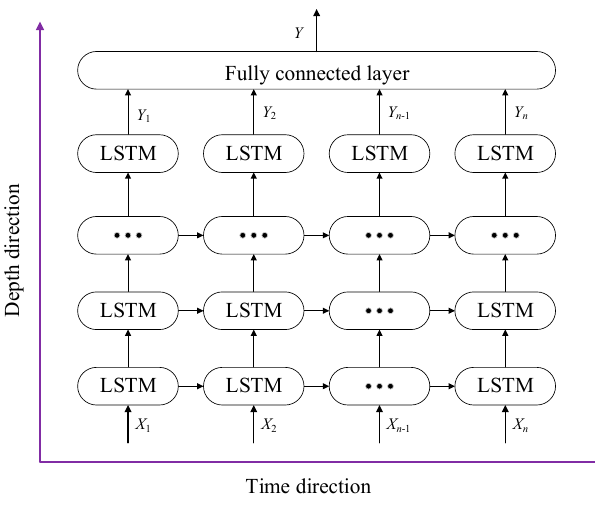
Figure 2. Architecture of the stack long short-term memory (SLSTM) network.